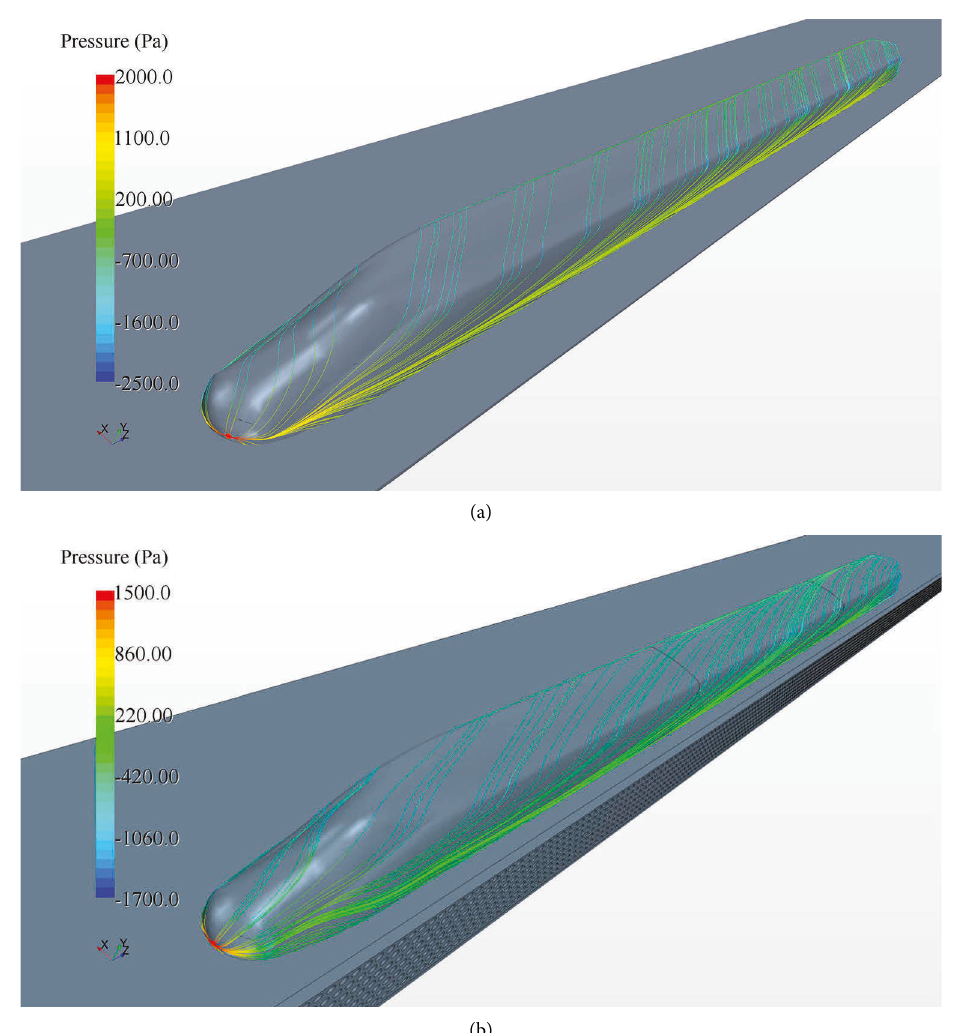
Figure 8: Surface streamlines on the train filed in pressure: (a) with no wind barrier and (b) with a wind